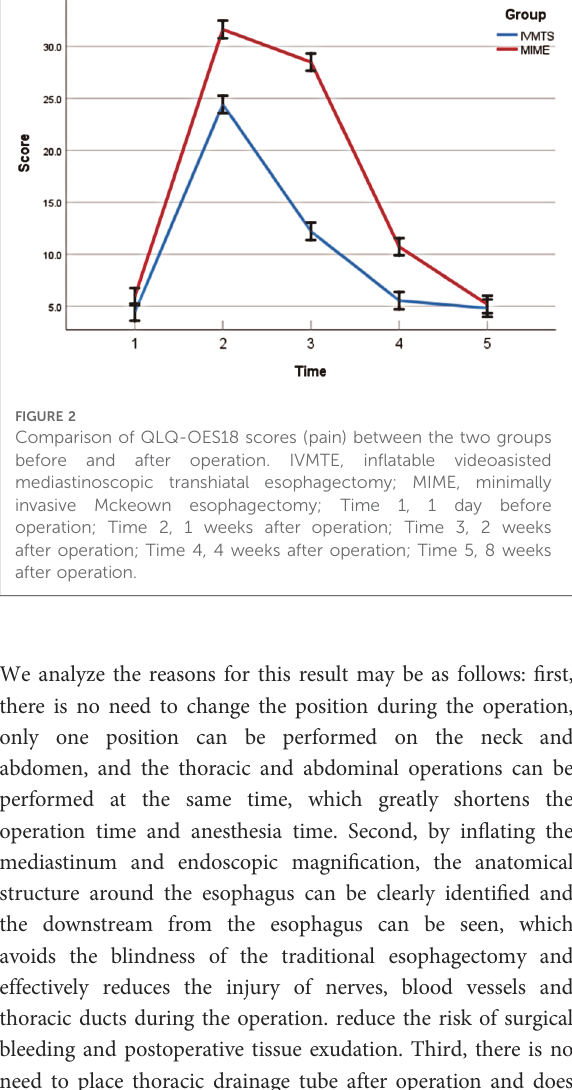
TABLE 5 Quality of life scores in IVMTE and MIME using QLQ-OES18. Mean square